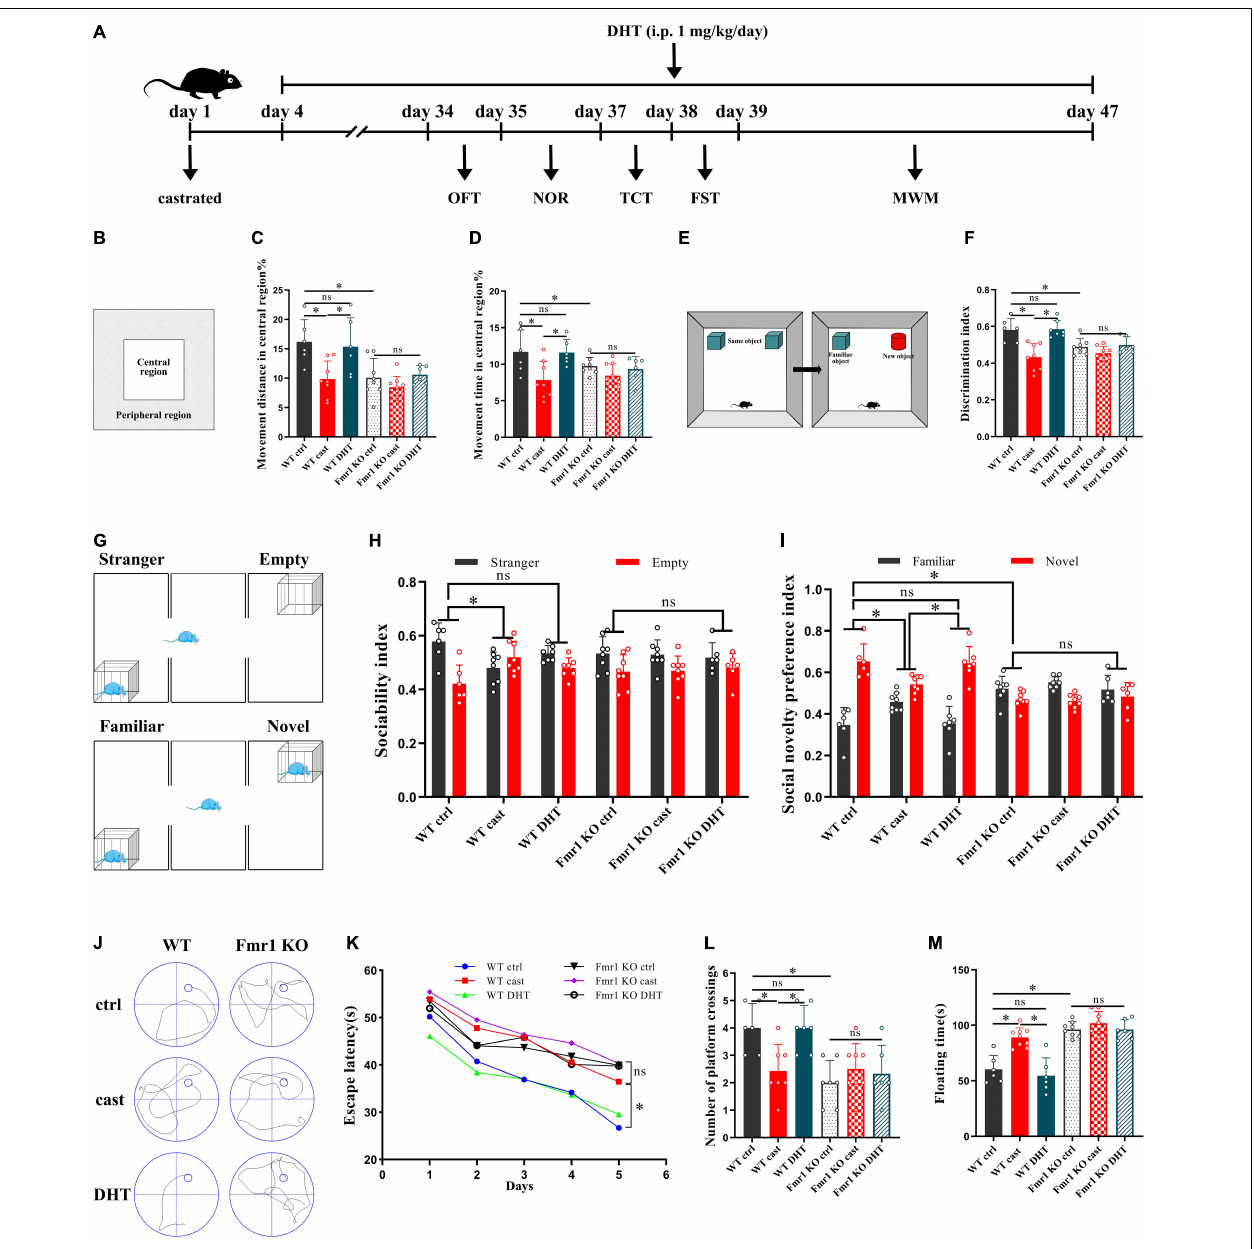
FIGURE 5 | Effects of castration and DHT supplementation on the behaviors of Fmr1 KO mice. (A) Experimental procedure. Mice were treated with castration, DHT (i.p., 1 mg/kg/day), and behavioral tests. (B) Schematic diagram of the OFT. (C,D) OFT was performed to assess exploratory behavior. (E) Schematic diagram of the NOR. (F) NOR was performed to assess memory retention. (G) Schematic diagram of the TCT. (H,I) TCT was performed to test for sociability and social novelty preference. (J) Trajectories of the MWM (the 5th day). (K,L) MWM was performed to test for learning and memory. (M) FST was performed to assess depressive-like behavior (* p <